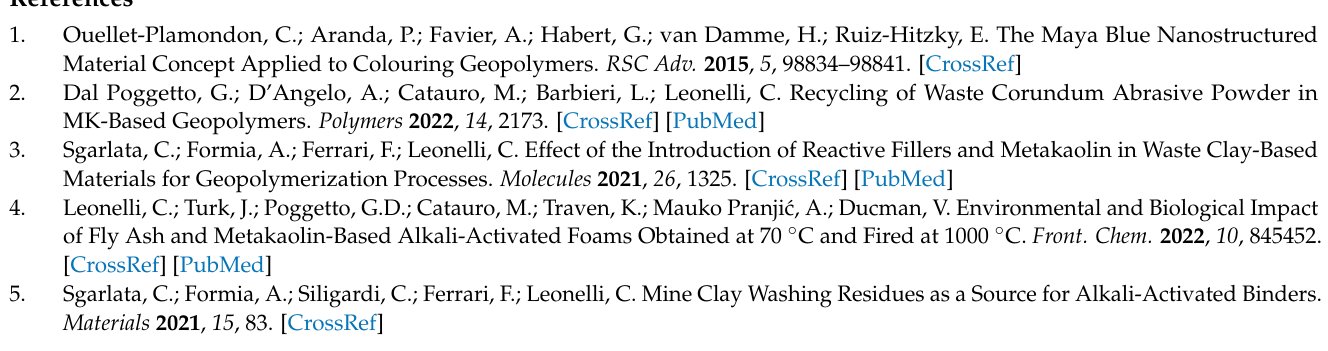
Figure 15. Leaching test of MK powder and GP1 and GP2 extracted after 56 days of ageing. The error due to the preparation procedure is between 20% and 30%.